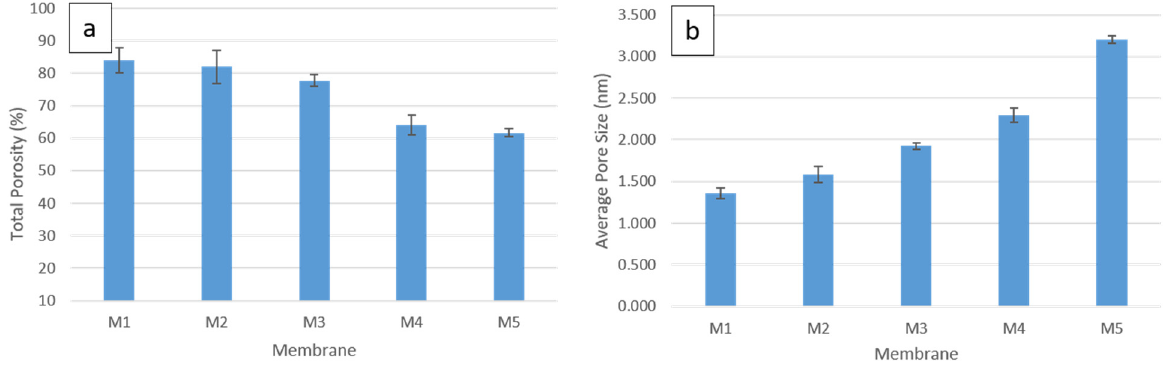
Figure 10. Pore morphology analysis for all fabricated membranes: ( a ) total porosity and ( b ) average pore size.